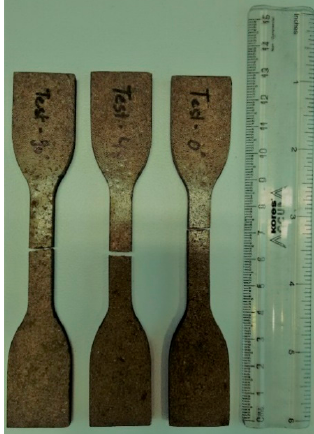
Figure 4. Tensile tested samples cut from WPC panel in 0°, 45° and 90°.